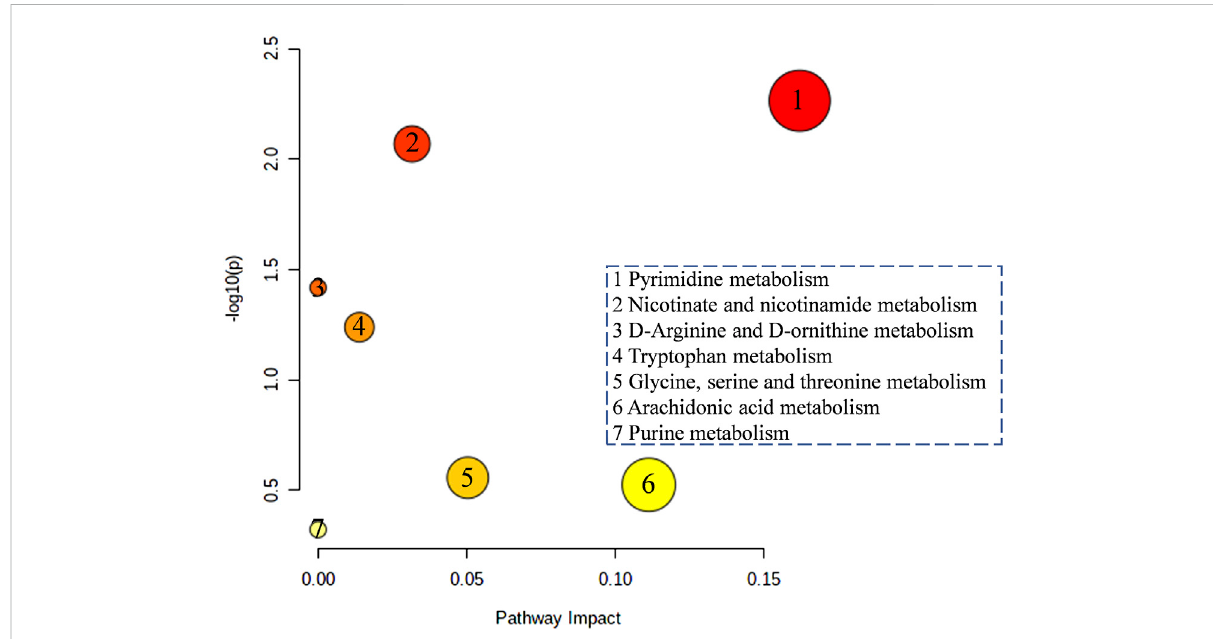
The function enrichment analysis of the four typical “ hot ” property herbs affected by the hypothyroidism